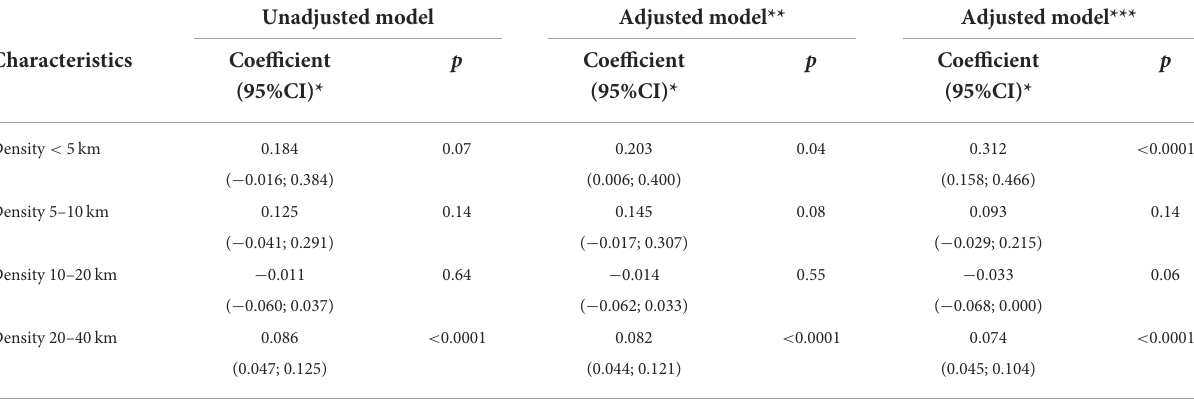
*Regressioncoefficientfromlinearmixedmodelwith95%confidenceinterval. **AdjustedmodelwithGP’sgender,performanceofsmearsbytheGP. ***AdjustedmodelwithGP’sgender,performanceofsmearsbytheGPandEDI.